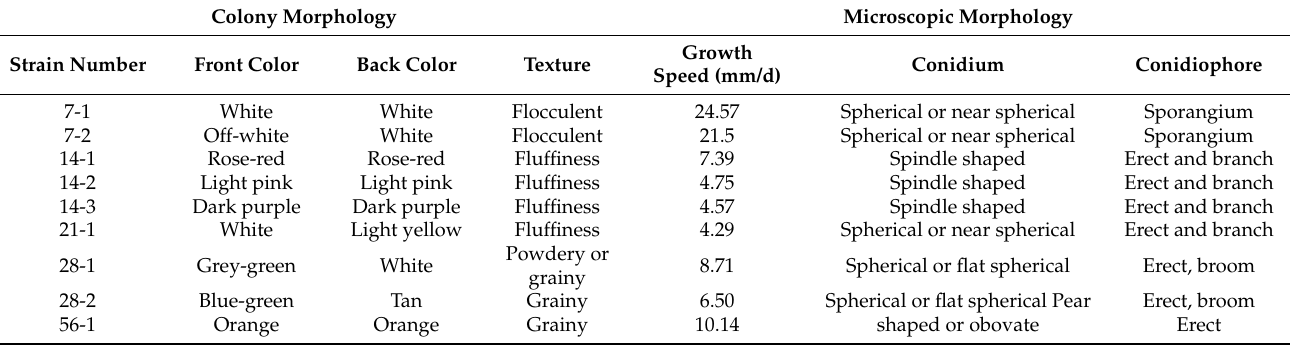
Table 2. Morphological characteristics of pathogens isolated at different storage